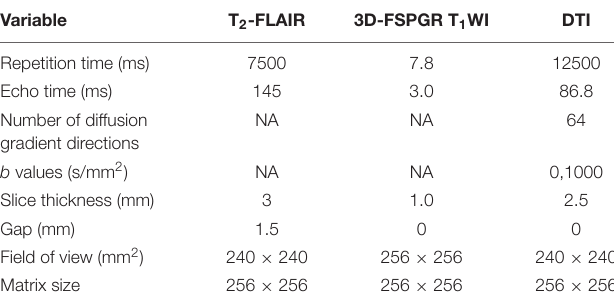
TABLE 2 | Scan parameters of the MRI